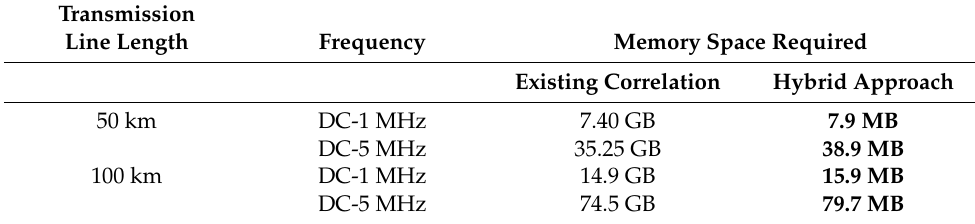
Table 7. Memory space requirement: comparison between the existing correlation estimator and the hybrid